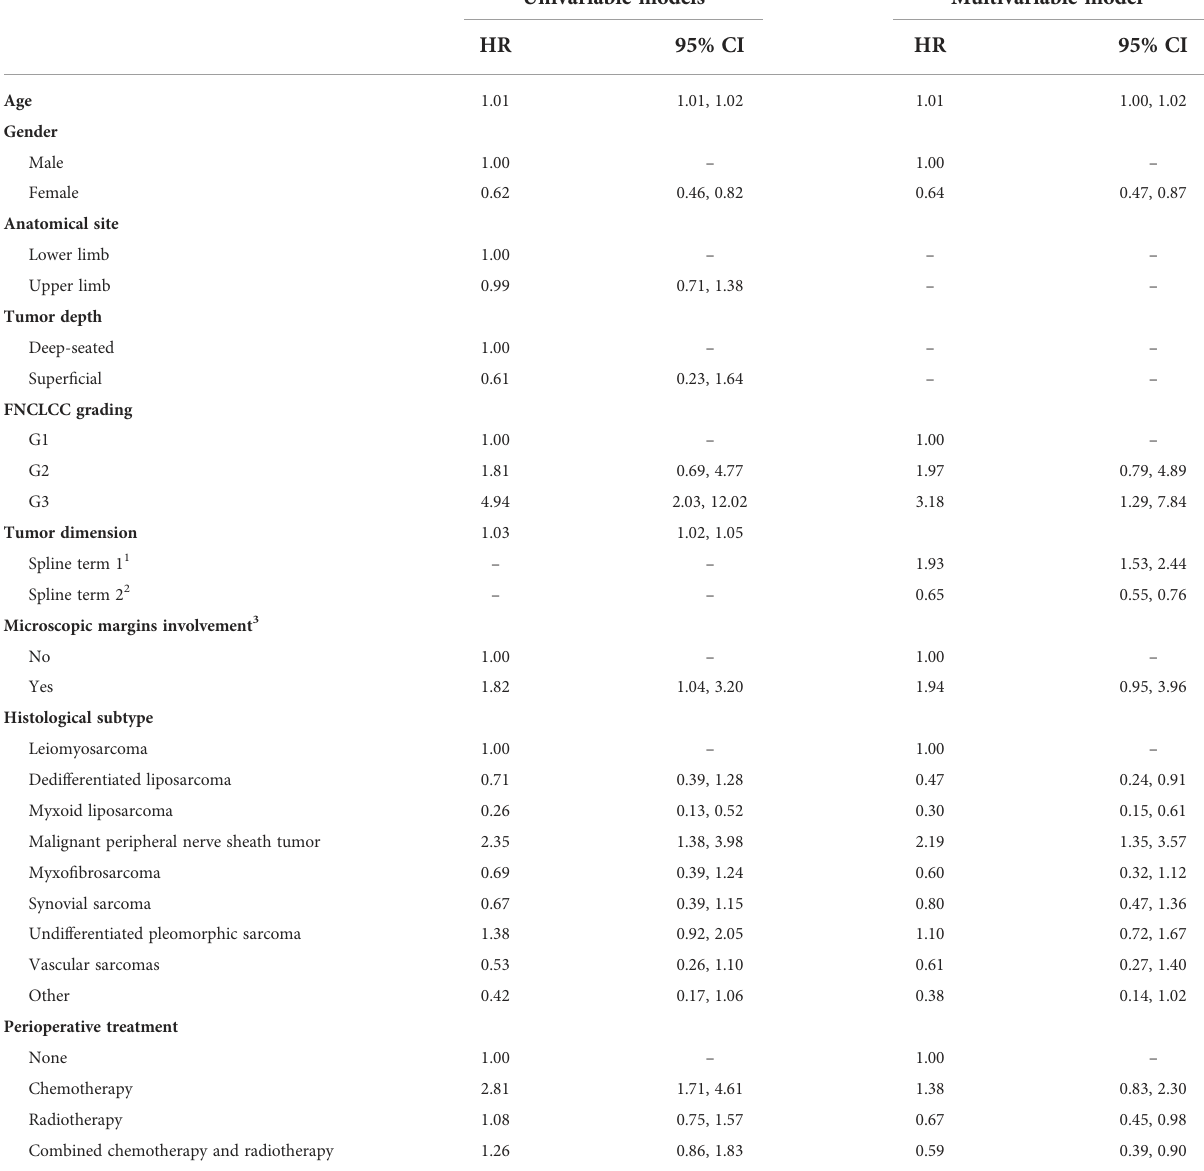
TABLE 2 Hazard ratios and 95% con fi dence intervals from the univariable and multivariable Cox proportional hazards models predicting 10-year sarcoma-speci fi c